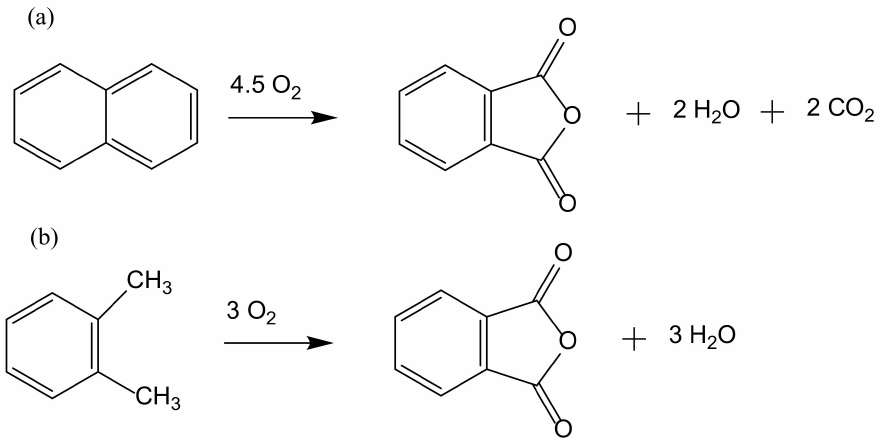
Figure 3. Oxidation of naphthalene ( a ) and o -xylene ( b ) to phthalic